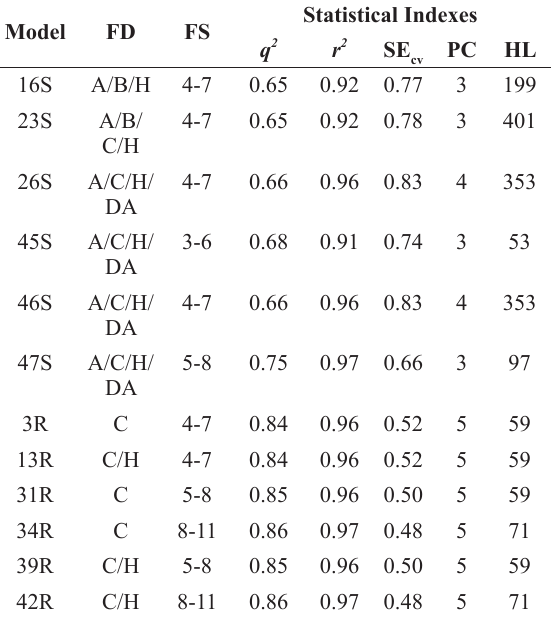
Best models summary of HQSAR statistical indexes of β-ketoesters derivatives asymmetric bioreduction for the influence of various fragment size (FS), using atoms, bonds, connectivity, hydrogen atom and hydrogen bond donor/acceptor groups as the fragment distinction (FD)